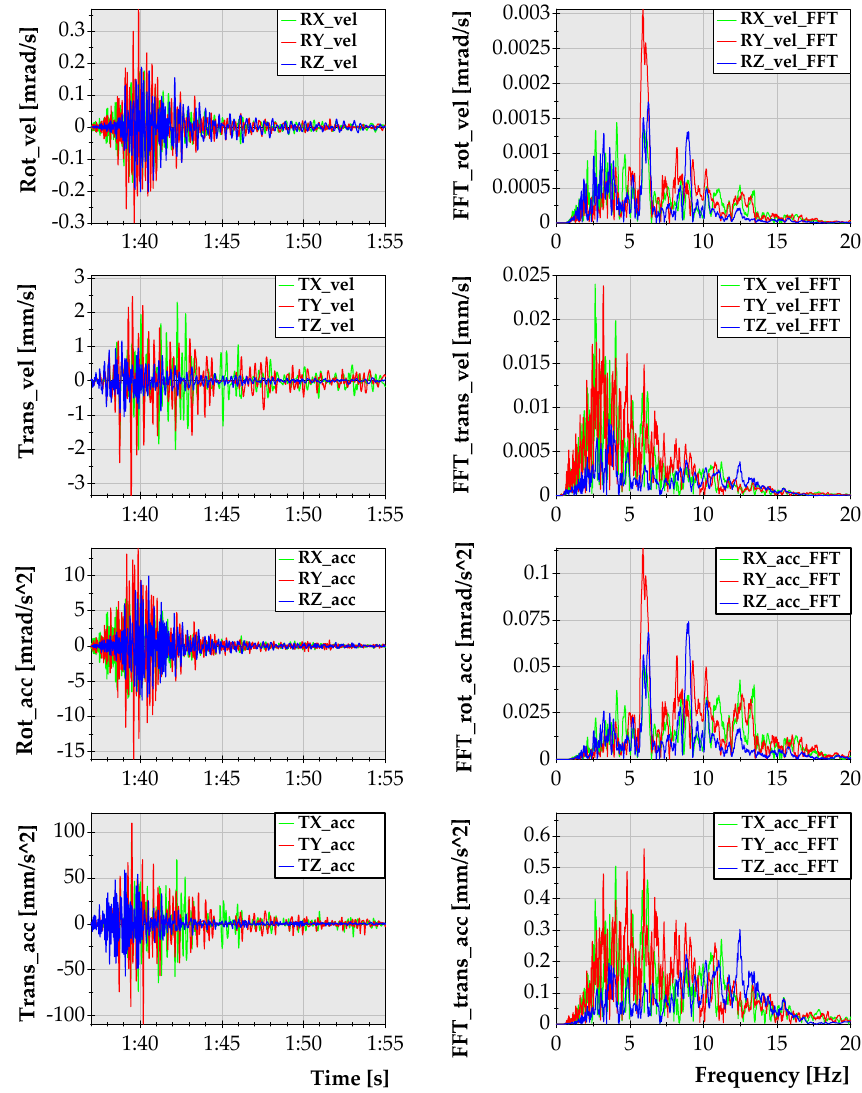
Figure 3. Amplitude ( left ) and frequency ( right ) characteristics of the velocity and acceleration waveforms generated by the tremor of energy of E = 3.1 × 10 8 J that occurred at a distance of 4446 m from the seismic